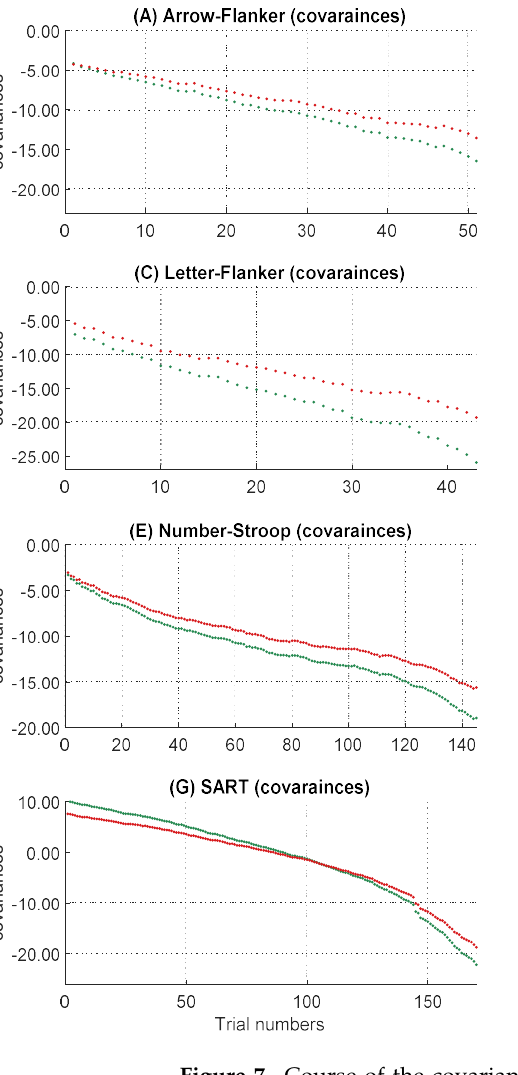
Figure 7. Course of the covariances and correlations over the RT distributions before and after controlling for the influence of the attentional lapses covariates. The courses of the covariances in the four different tasks are shown on the left side ( A , C , E , G ). The courses of the correlations in the four different tasks are shown on the right side ( B , D , F , H ). The figure describes the worst performance pattern before (green and blue lines) and after (red lines) the TUTs covariate were partialized out of the covariance.